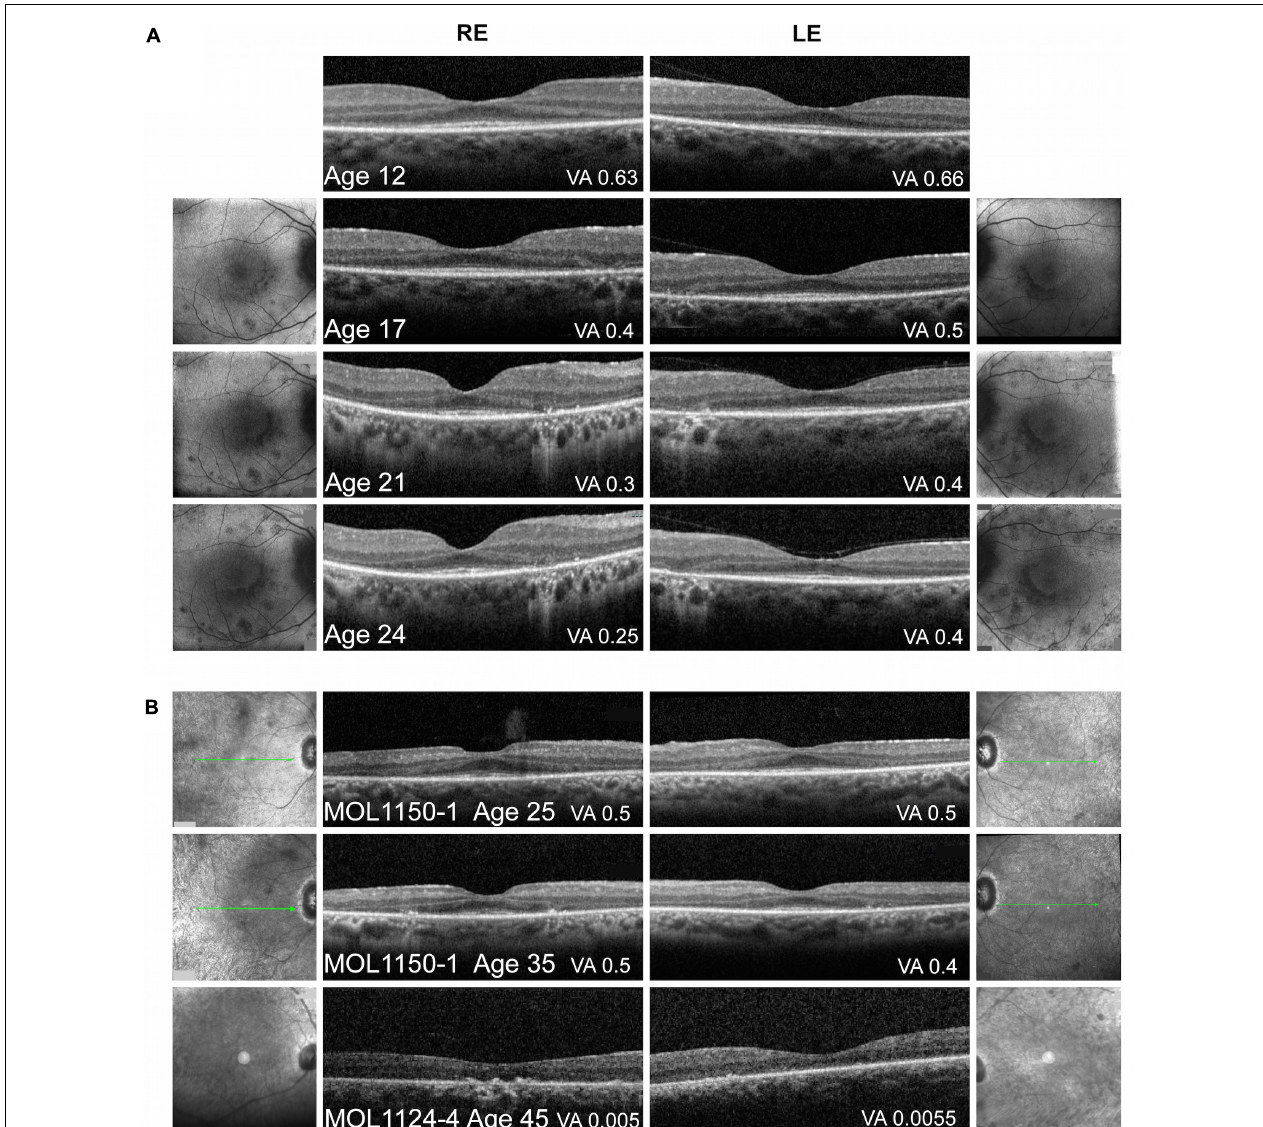
FIGURE 4 | Macular imaging. (A) Representative macular FAF and foveal OCT images of MOL0358-1 over time. Thinning of the photoreceptor layer and narrowing of the central area of ONL and intact EZ can be observed with time. FAF imaging shows increase in the number and size of hypoautofluorescent spots in the macular area along time, some encircling the central macula, with a faint hyperautofluorescent ring around the fovea. The BCVA measured on the day of OCT imaging is specified in the right bottom corner of each scan. (B) Macular OCT images from patient MOL1150-1 at the ages of 25 and 35 again show increased thinning of the photoreceptor layer and loss of intact EZ width with age. In patient MOL1124-4 at the age of 45, ONL and EZ are practically lost. The BCVA measured on the day of OCT imaging is specified in the right bottom corner of each